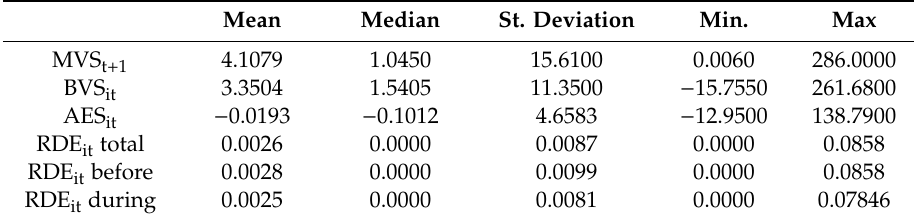
Table 1. Descriptive statistics.